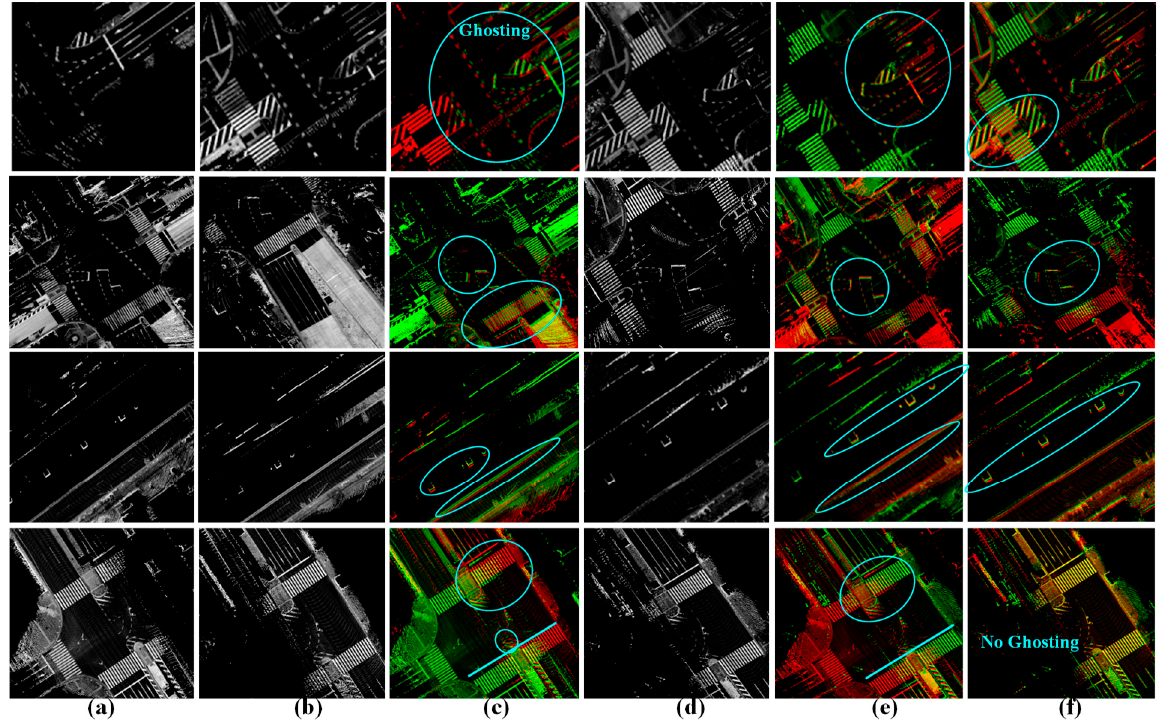
Figure 7. Ghosting (indicated by ellipses) in GIR map of the three segments in Figure 6a. ( a , b ) Repre- sentation of local loop closures in the first collection phase in opposite directions. ( c ) GIR map images with ghosting effects and deviations in landmarks. ( d ) Single scans by the second collection phase. ( e , f ) Map combination: individual merging of images in ( d ) with ( a , b ),